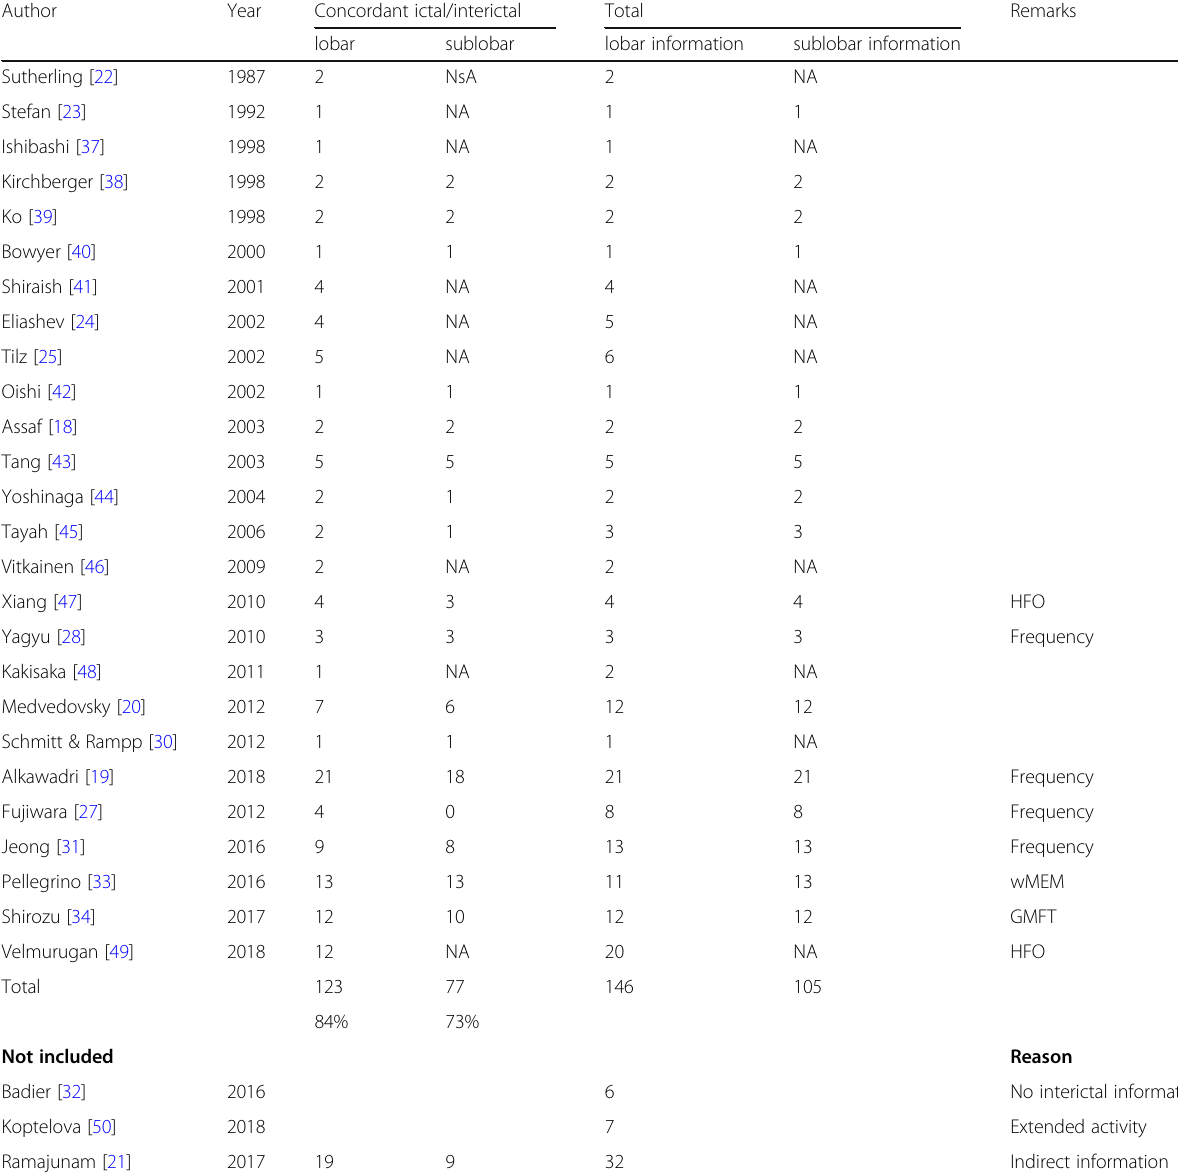
Table 2 Concordance of interictal and ictal magnetic source imaging (MSI) on lobar and sublobar levels